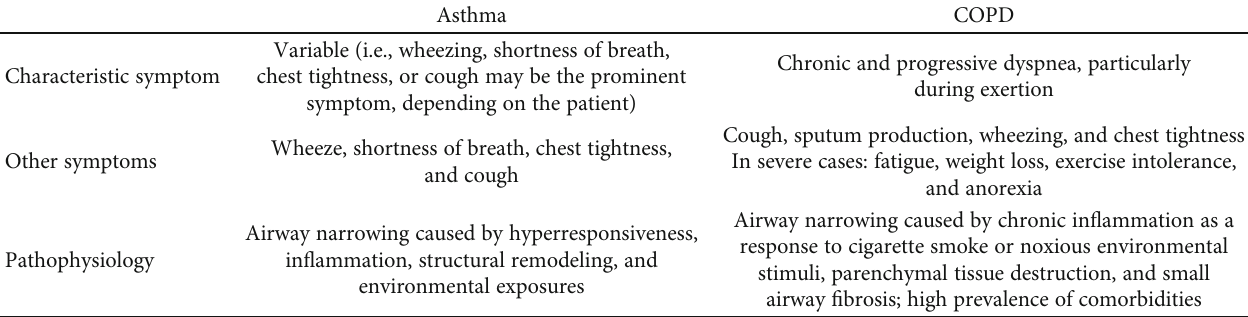
Table 1: Di ff erences between asthma and COPD presentation, etiology, and pathophysiology [2, 3].